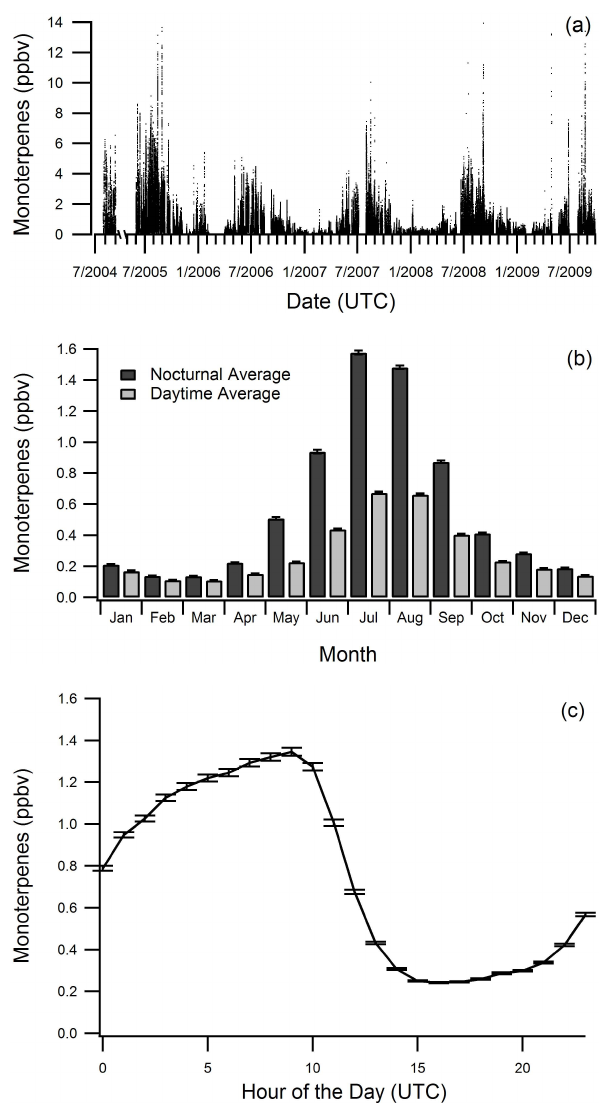
Fig. 2. (a) The data set of monoterpenes collected by PTR-MS at Thompson Farm from 2004 to 2009, showing daily, seasonal, and inter-annual variability. (b) The monthly average daytime and noc- turnal average mixing ratio of monoterpenes, showing that monoter- pene mixing ratios are elevated at night during the summer months. (c) The average mixing ratio of monoterpenes as a function of the time of day from May through September, showing mixing ratios increasing throughout the night and decreasing at daybreak.